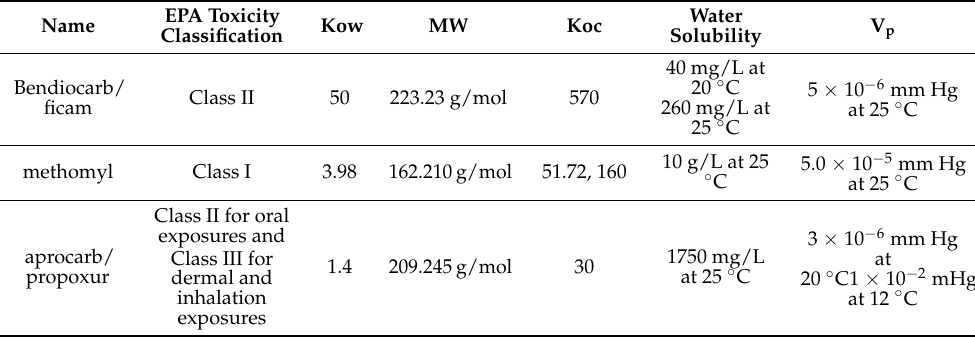
Table 6. Summary of physicochemical properties of some carbamates